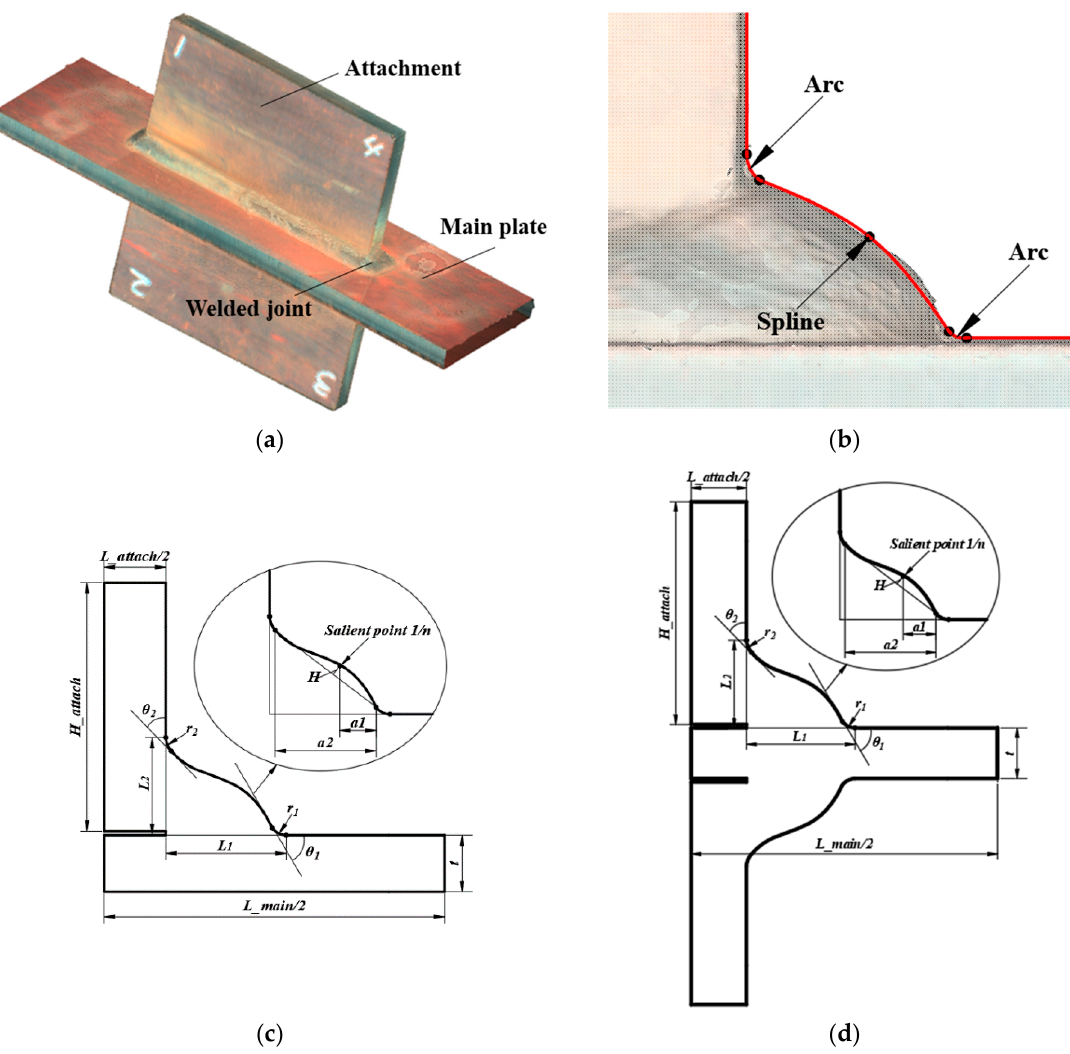
Figure 1. The spline model: ( a ) double-attachment gusset; ( b ) bead shape; ( c ) spline model for single attachment; ( d ) spline model for double